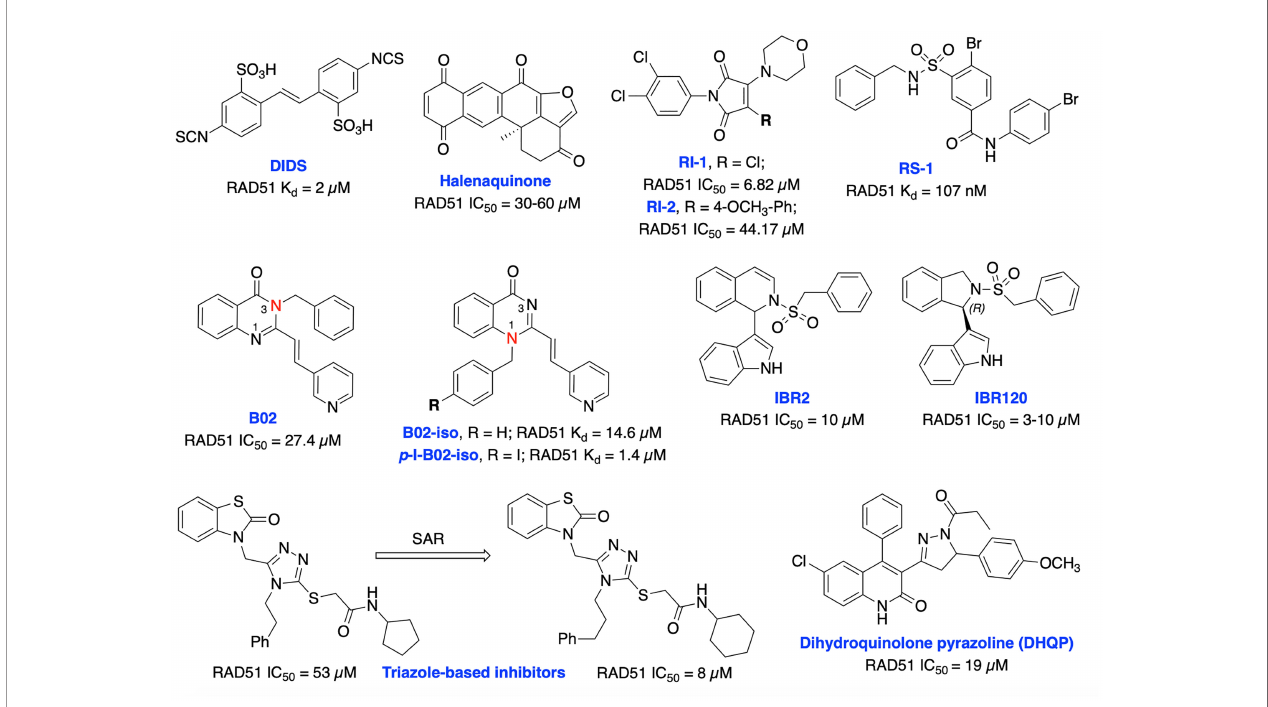
FIGURE 10 | Small molecule inhibitors targeting RAD51 with their respective Kd/IC50 values for either disruption of RAD51 binding or RAD51 mediated D-loop